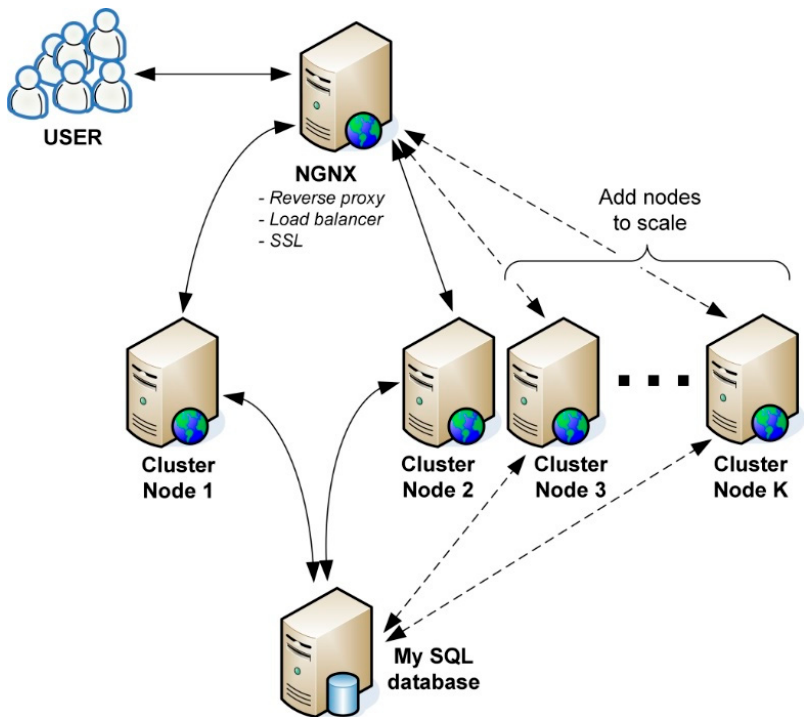
Figure 5. An example solution for the Web cluster.